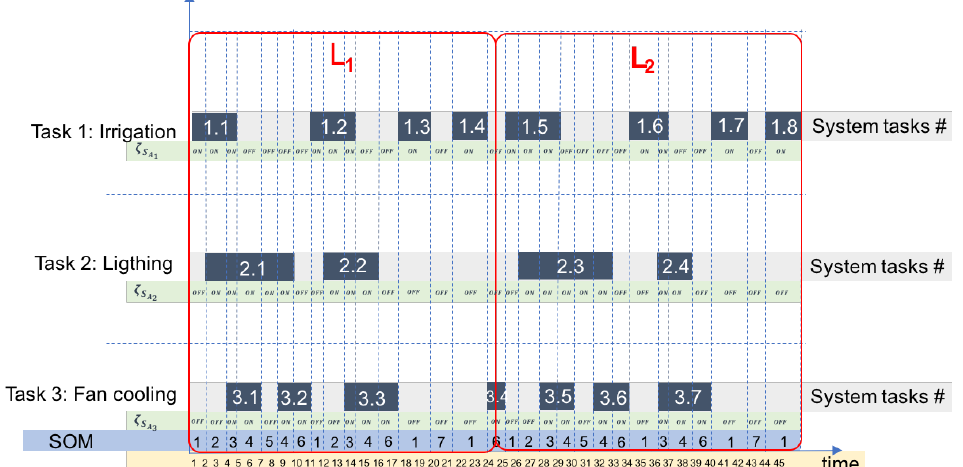
Figure 2. Tasks versus time diagram.